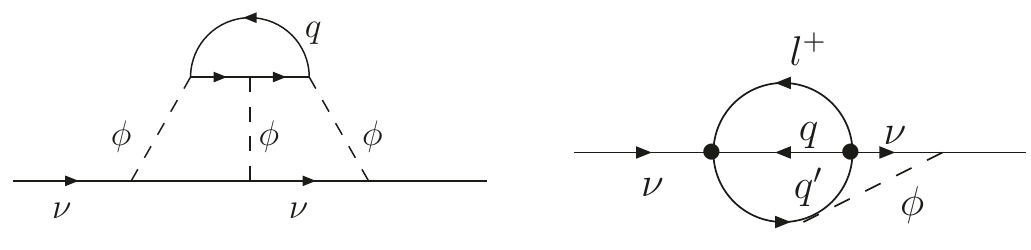
Figure 2 . Three loop contributions to neutrino mass. The dots denote charged current weak Figure 1: One-loop contribution to neutrino mass interaction